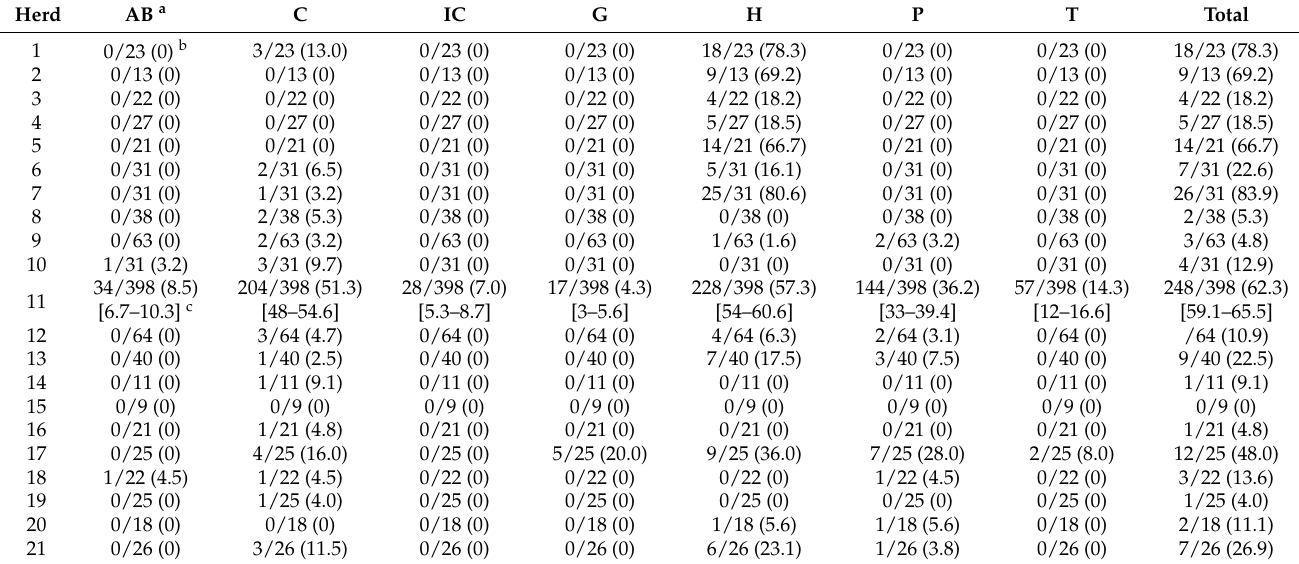
Table 4. Within-herd Leptospira seroprevalence in animals from 20 unvaccinated dairy herds and one vaccinated (herd n. 11) dairy herd in Boyac á department (Columbia) that were tested for antibodies to 7 Leptospira serovars using microscopic agglutination